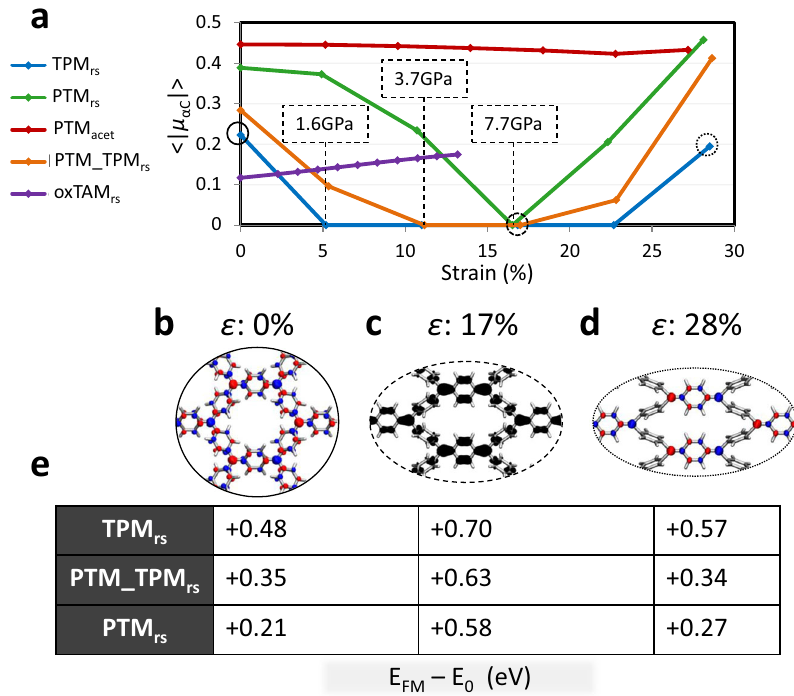
Fig. 4 Electronic response to strain. a Average of the absolute spin population per α C for each studied 2D-CORF versus uniaxial strain. Estimated in-plane tensile stresses required to induce the AFM-to-quinoidal transition are indicated for TPM rs , PTM_TPM rs and PTM rs . b Spin density iso-surface (spin up: blue; spin down: red) for TPM rs when relaxed ( ε = 0%). c Highest occupied crystal orbital density (black) for the semi-strained conformation of TPM rs ( ε = 17%). d Spin density iso-surface for highly strained TPM rs ( ε = 28.5%). e Relative energy per α C (in eV) of the ferromagnetic electronic solution ( E FM ) with respect to the electronic ground state ( E 0 ) at each conformation ( b – d ) for TPM rs , PTM_TPM rs and PTM rs . For the cases when the AFM solution is the ground state these energy differences are related to the degree of magnetic coupling (see also Table S2 in the